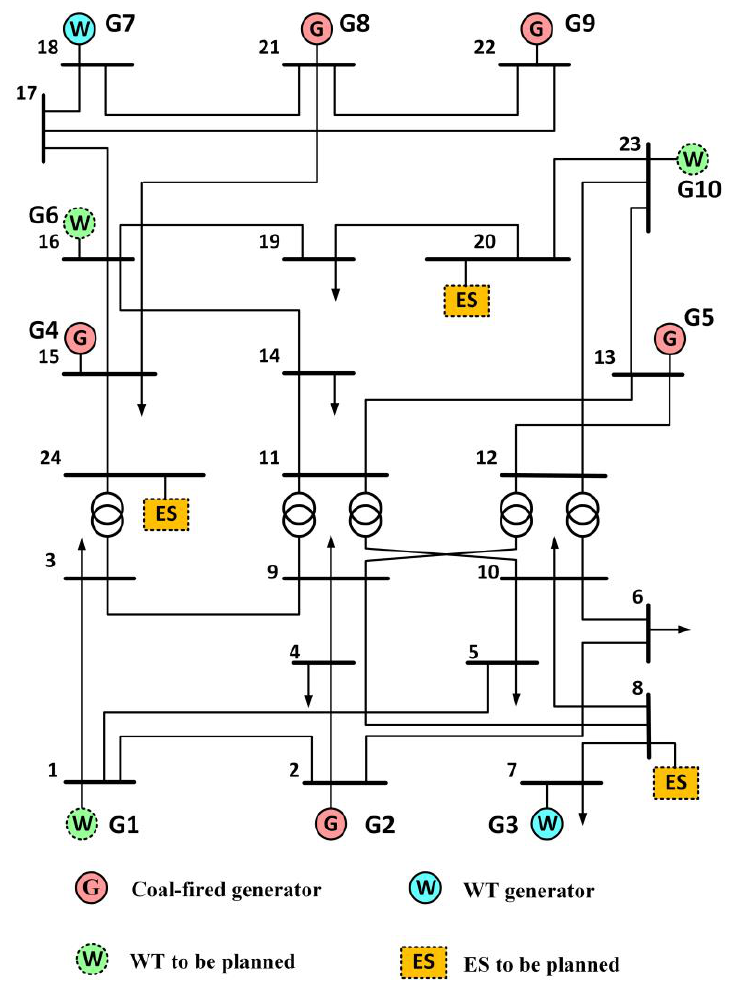
Figure 2. The modified IEEE 24-bus power system. Table 1. Parameters of